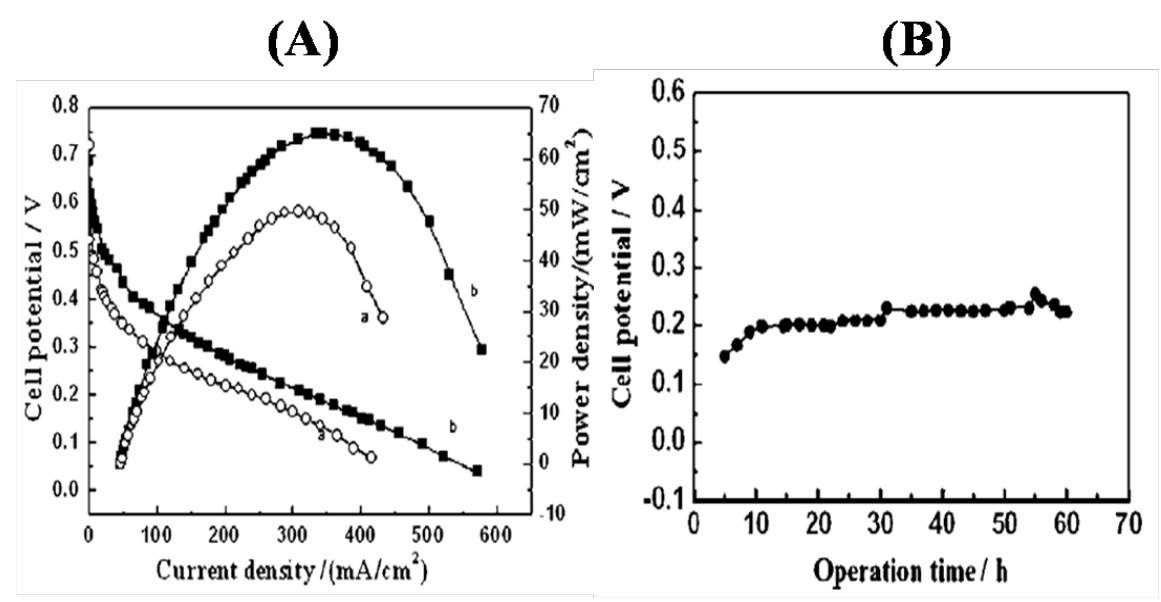
Figure 15. (A) Cell polarization curves of single cells with different cathode catalysts cathode: (a) 18 wt% Mo N 0.609 mg/cm 2 ; (b) 18 wt% Mo 2 study for the Mo N/C electrocatalyst cathode: 18 wt% Mo 2 from Reference 113 with